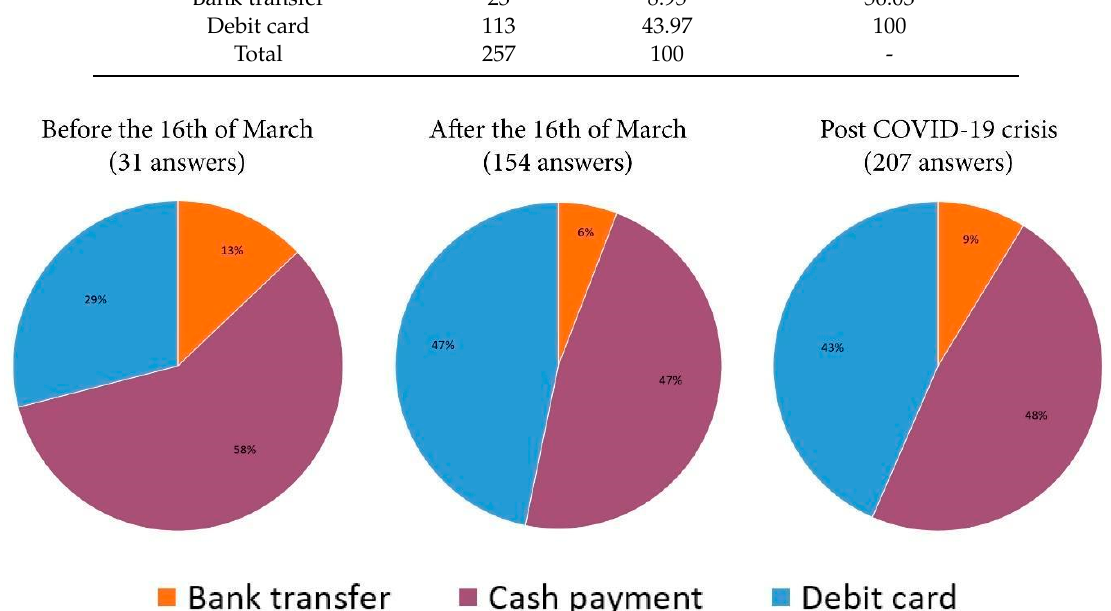
Figure 13. The preferred payment method of the consumers who ordered before and after March 16 and post COVID-19 crisis.